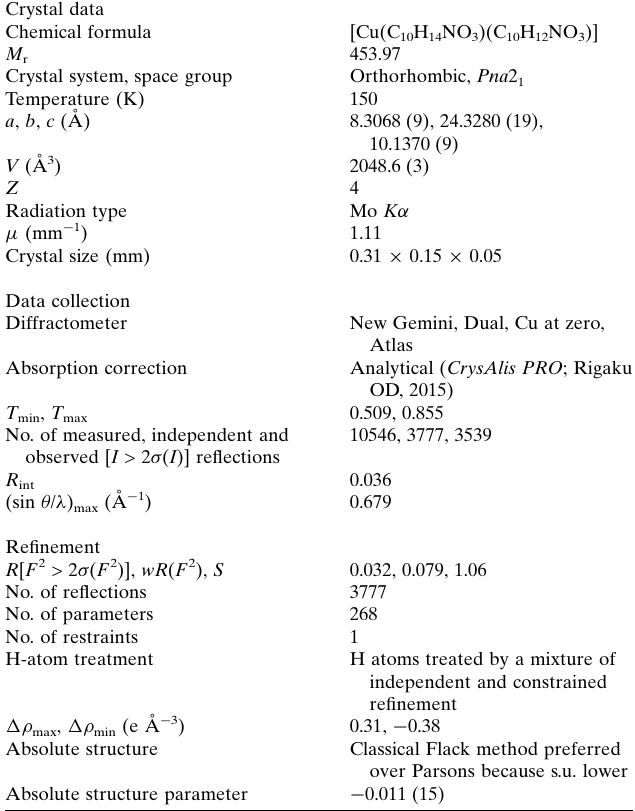
Table 2 Experimental details. Crystal data Chemical formula